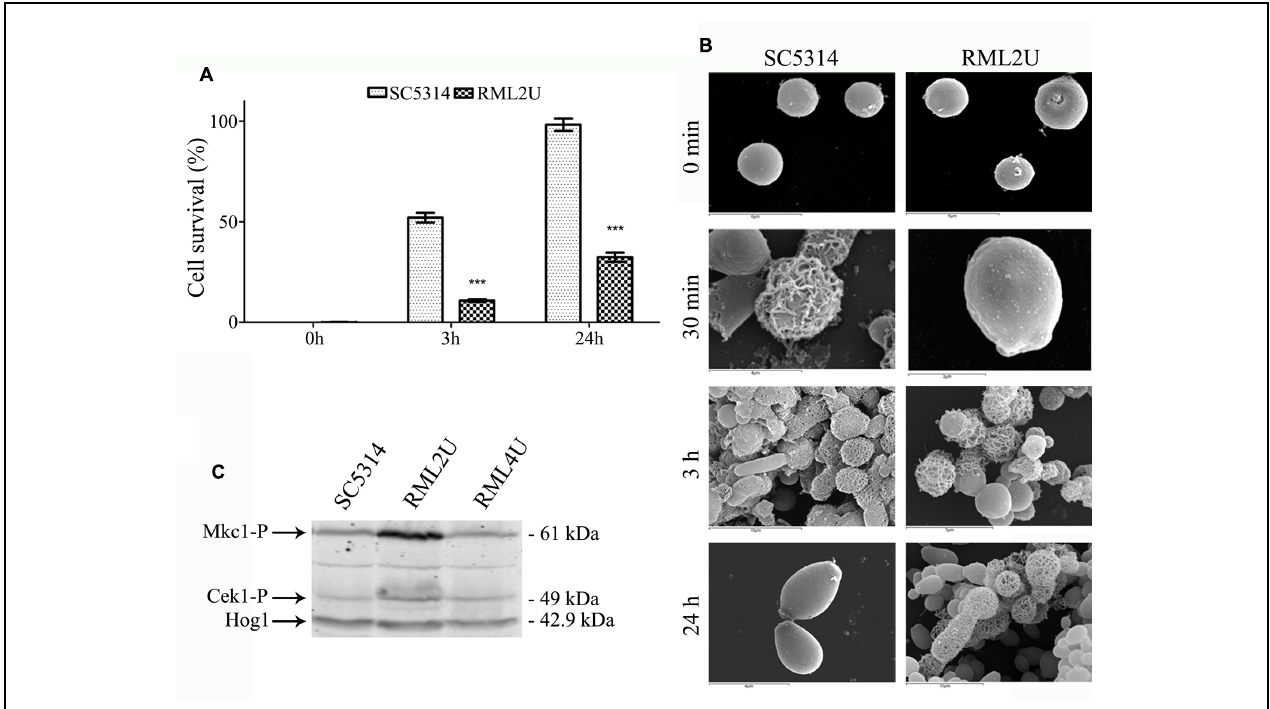
FIGURE 1 | Protoplast regeneration and CWI activation. (A) Comparison of the percentage of viable counts of osmotically stabilized shocked cultures of Candida albicans cells. Statistically significant differences relative to the wild-type are indicated ( ∗∗∗ p < 0.001). (B) Scanning electron microscopy (SEM) of